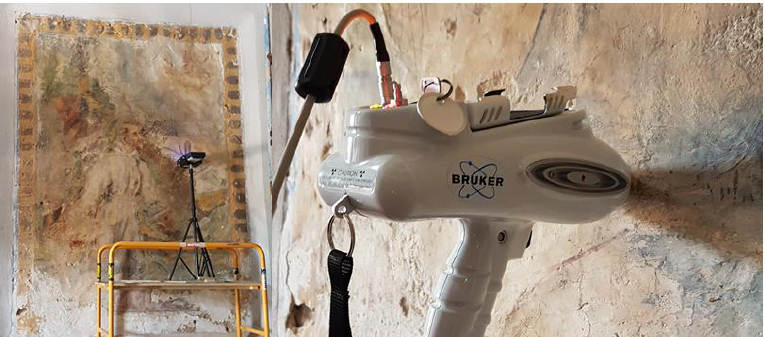
Figure 2. Wall painting of St. Francis inside Church of S. Maria delle Palate during the measurement’s